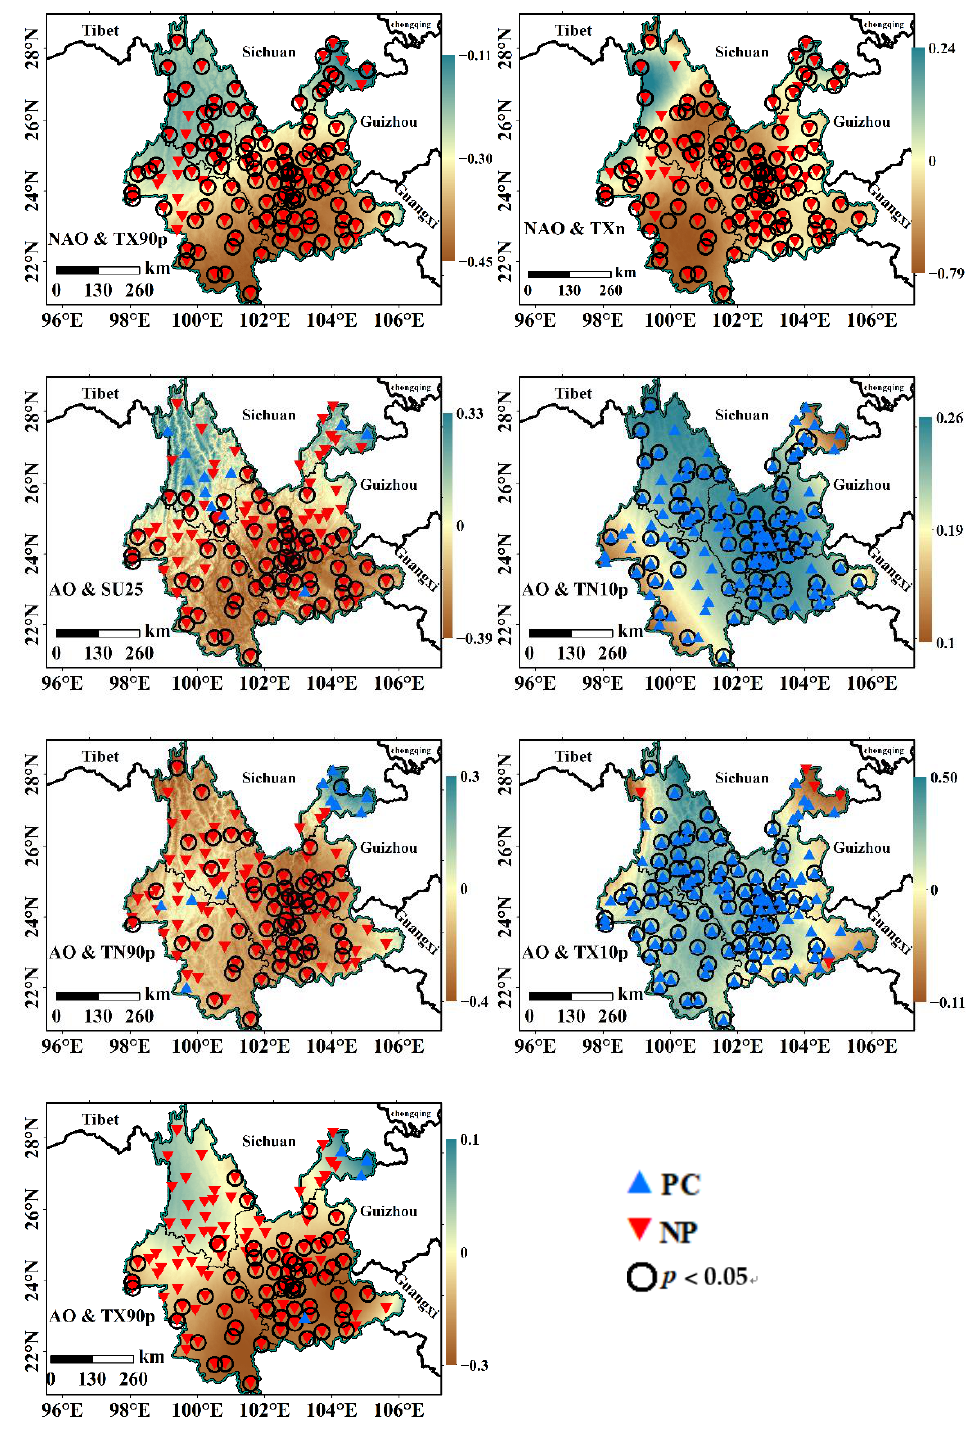
Figure 7. Spatial distribution of the correlation between extreme climate indices and general circu- lation patterns in Yunnan. Notes: PC represents a positive correlation and NC represents a negative correlation. p < 0.05 indicates that the correlation passes the significance test of p = 0.05.